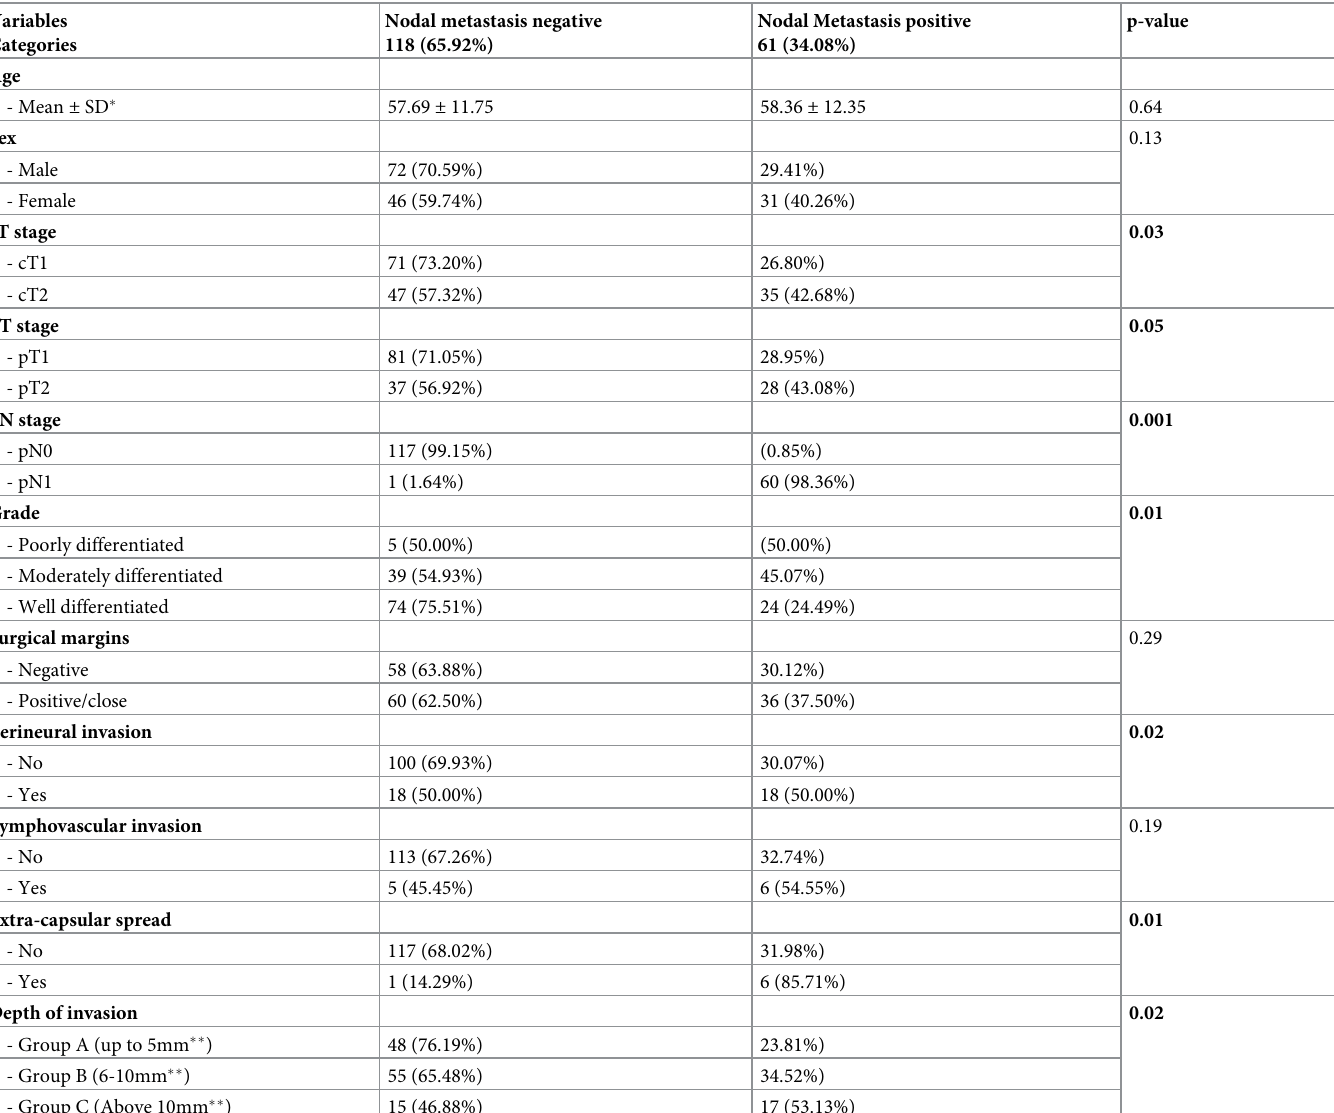
Table 3. Association of clinicopathological characteristics with nodal